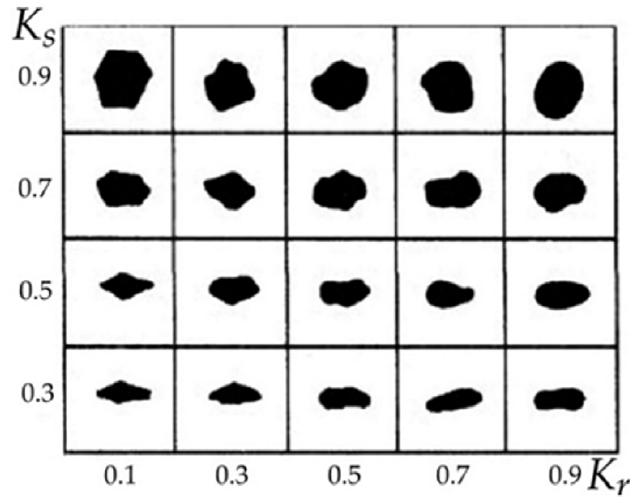
Figure 2. Diagram for visual determination of the values of the coefficients of roundness, K r , and sphericality, K s , of particulate matter of mechanical impurities.